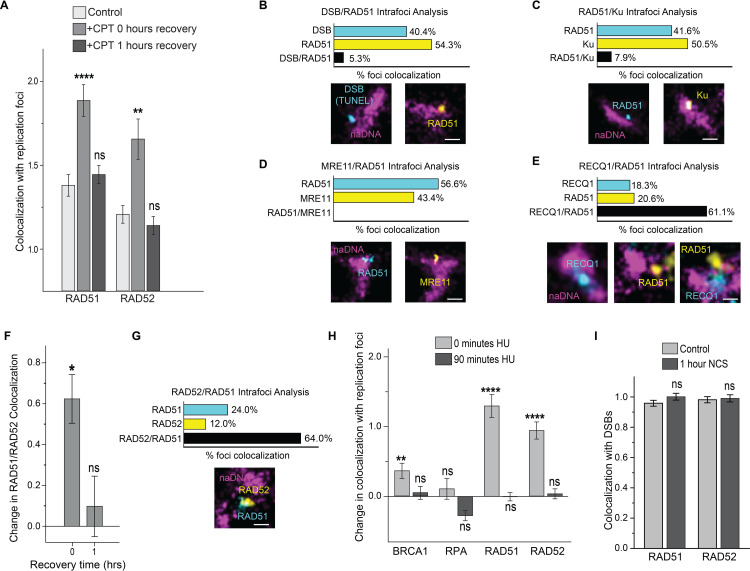
RAD51 and RAD52 are first responders to stalled/regressed RFs.(A) Quantification of RAD51 and RAD52 colocalization with RF foci immediately after CPT damage and following 1 hour of recovery. Representative whole-cell control and CPT-treated cells shown in S10A and S10B Fig. (B) Three color analysis of RAD51 and DSB (TUNEL) localization at RF foci immediately following 1 hour of CPT damage. Representative whole-cell control and CPT-treated cells shown in S10C and S10D Fig. (C) Three color analysis of RAD51 and Ku localization at RF foci immediately following 1 hour of CPT damage. Representative whole-cell control and CPT-treated cells shown in S10E and S10F Fig. (D) Three color analysis of RAD51 and MRE11 localization at RF foci immediately following 1 hour of CPT damage. Representative whole-cell control and CPT-treated cells shown in S10G and S10H Fig. (E) Three color analysis of RAD51 and RECQ1 localization at RF foci immediately following 1 hour of CPT damage. Representative whole-cell control and CPT-treated cells shown in S10I and S10J Fig. (F) Quantification of colocalization of RAD51/RAD52 immediately following 1 hour of CPT treatment and after 1 hour of recovery in normal medium, normalized to control levels. (G) Three color analysis of RAD52 and RAD51 localization at RF foci immediately following 1 hour of CPT damage. Representative whole-cell control and CPT-treated cells shown in S10A and S10B Fig. (H) Quantification of protein colocalization with naDNA RF foci at unbroken HU-stressed RFs immediately following 4 hours of HU treatment and after 90 minutes of recovery in normal medium from HU treatment, normalized to control levels. (I) Quantification of RAD51 and RAD52 colocalization with DSBs (TUNEL signal) in control and NCS-damaged cells. Representative foci shown, scale bars represent 250 nm. Complete N values available in S1 and S2 Tables, number of replicates >3, number of cells imaged typically 20–60, number of individual foci manually scored typically 50–70. All graphs show mean ± s.e.m. Student’s t-test results shown for comparison with control levels: ns depicts p>0.05, * depicts p<0.05, ** depicts p<0.01, **** depicts p<0.0001.